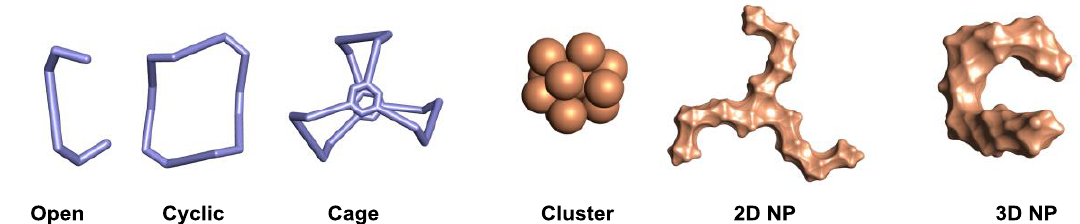
Figure 5. Different examples of systems presenting individual chirality.